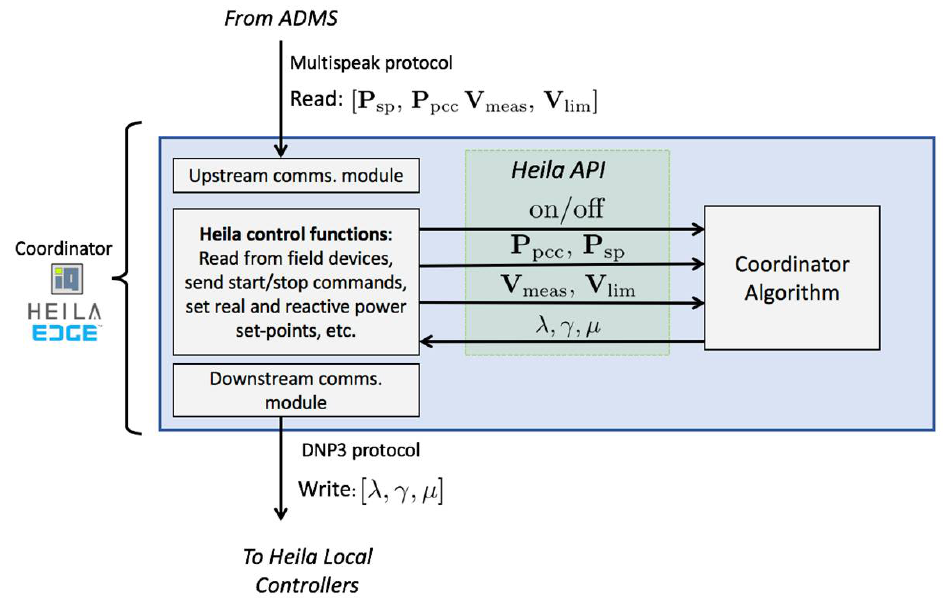
Figure 5. Illustration of Heila DERMS coordinator implementation.